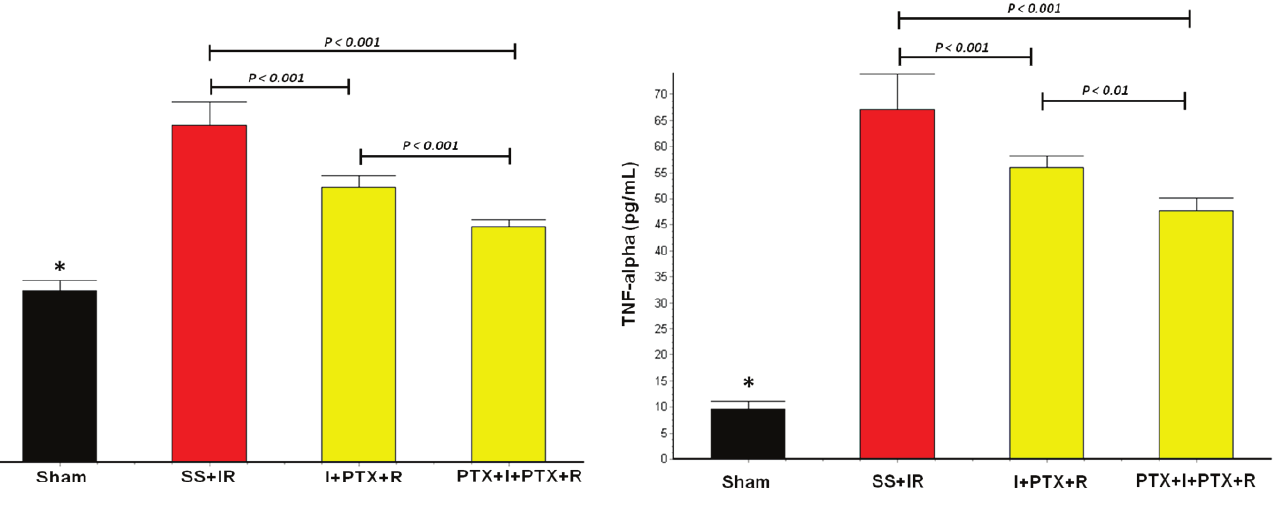
FIGURE 2 - Effect of pentoxifylline treatment on lipid-derived oxidation products as determined by the levels of thiobarbituric acid reactive substance-malondiadehyde (TBARS-MDA) in rat lung homogenates. Groups are as in the legend to Figure 1. Data are mean ± SD. * P <0.001 regarding all other groups.